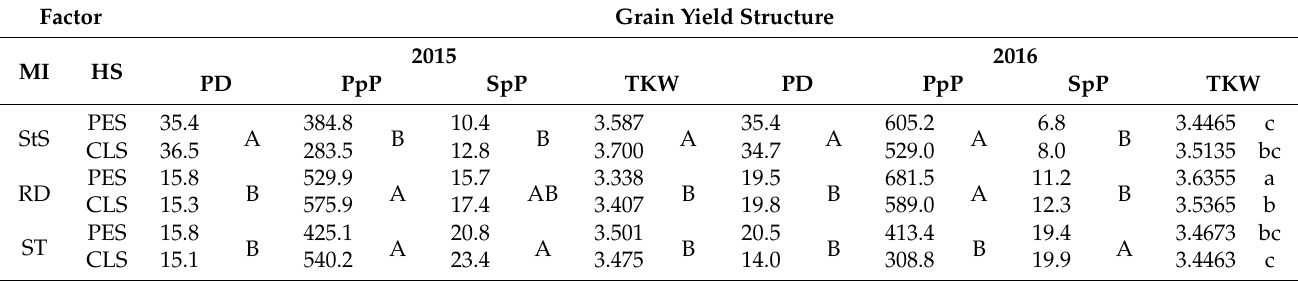
Table 2. Grain yield structure of Clearfield ® -oilseed rape as effect of different management intensities (MI) and herbicide strategies (HS) in the years 2015 and 2016, experimental station Ihinger Hof. StS: standard sowing (mouldboard ploughing, 50 seeds m − 2 , 12 cm row spacing); RD: reduced sowing density (mouldboard ploughing, 25 sown seeds m − 2 , 50 cm row spacing); ST: strip-till (strip tillage, 25 seeds m − 2 , 50 cm row spacing); PES: pre-emergence application of Colzor ® Trio and post-emergence application of Agil ® -S. CLS: post-emergence application of Clearfield ® -Vantiga ® -D. Grain yield structure elements: plant density (PD) in plants m − 2 , pods per plant (PpP), seeds per pod (SpP) and thousand-kernel weight (TKW) in g. Values labelled by the same letter are not significantly different. Capital letters refer to effects of MI; lowercase letters refer to interactions of MI × HS ( p ≤ 0.05; Student’s t